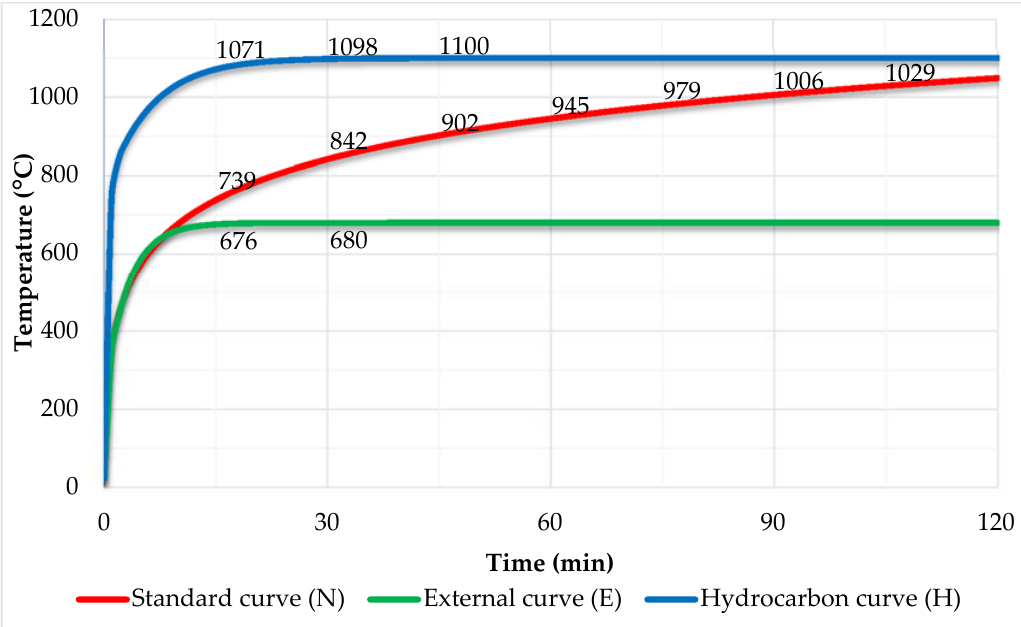
Figure 4. Summary of fire dependencies.